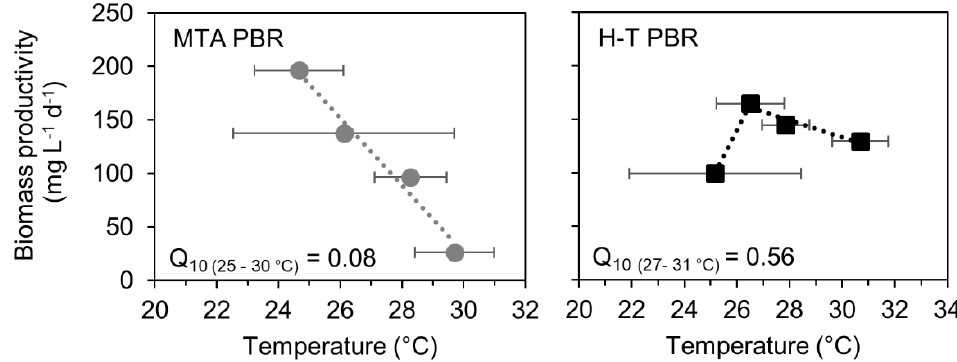
light grey error intervals represent standard deviations for H-T PBR and MTA PBR, respectively. The doted lines represent temperature profiles in days when minimal and maximal temperatures during the light phase of the day were detected (within each month). Temperature in FPA PBR was regulated to 25 °C.